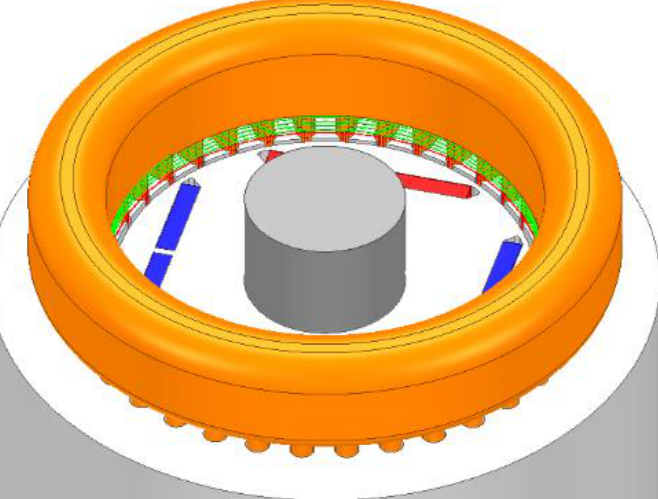
Figure 16. A 3D model with shielding windings: in the stator slot wedges and in the form of a helix under the stator end-winding. Table 3. Parasitic capacitances of the model with two shielding windings compared to the capaci- tance values of the reference model.